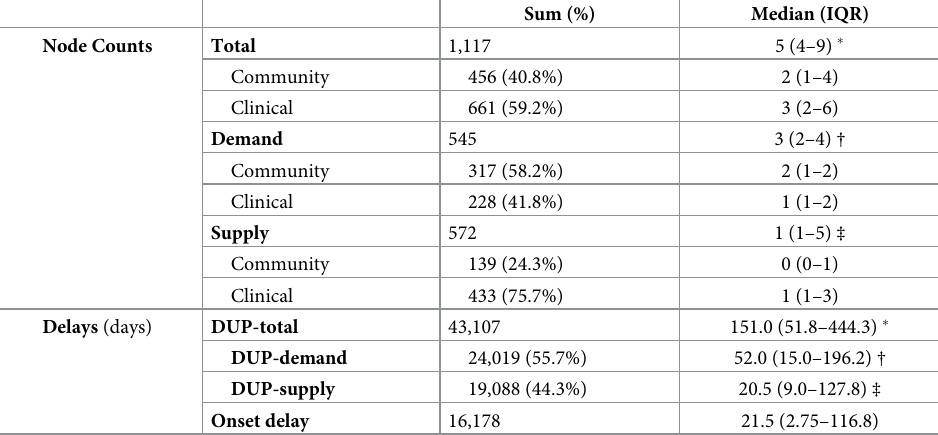
Table 2. Descriptive statistics of node counts and global delay measures delay with correlation